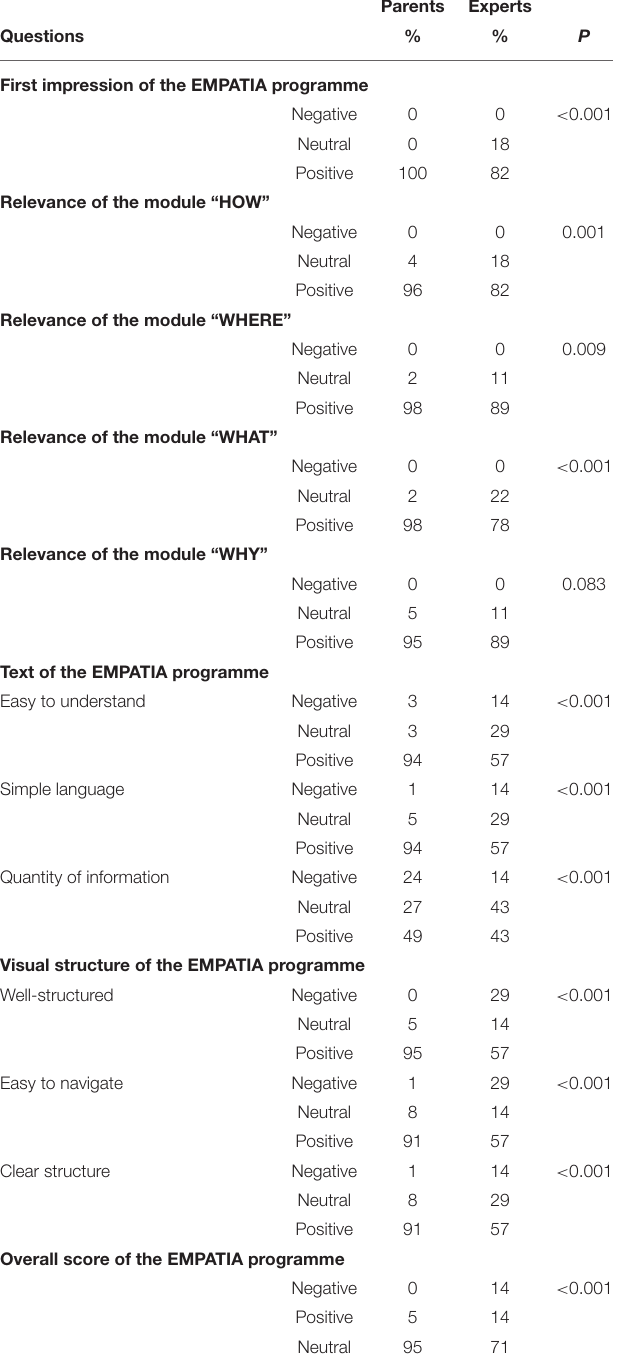
TABLE 1 | Frequency of occurrence (%) of negative, neutral, and positive evaluations of the EMPATIA programme and statistical comparisons ( p < 0.05) between parents of dual-career athletes and European dual-career